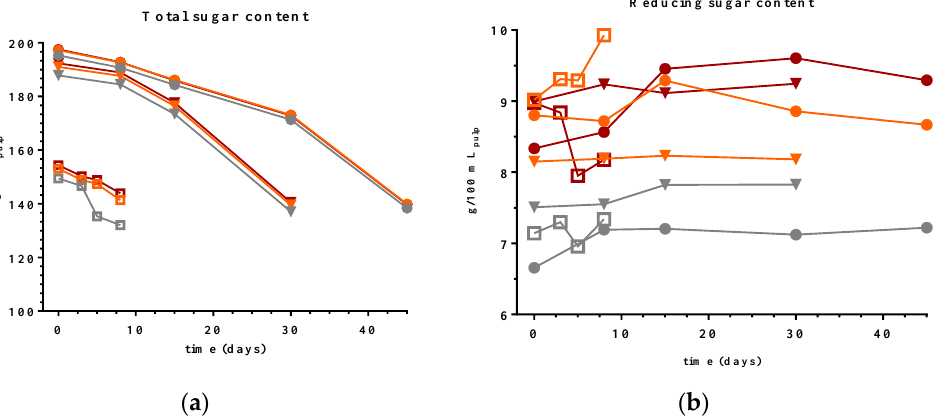
Figure 4. Variation in ( a ) total sugar content and ( b ) reducing sugar content over storage time in Figure 2 . Evaluation of the ( a ) pH and ( b ) titratable acidity in juices of O. ficus-indica versus storage Figure 2 . Evaluation of the ( a ) pH and ( b ) titratable acidity in juices of O. ficus-indica versus storage Figure 2 . Evaluation of the ( a ) pH and ( b ) titratable acidity in juices of O. ficus-indica versus storage prickly pear non-pasteurized samples (raw ( □ )) and the two processing methods (high-pressure time for non-pasteurized samples (raw ( □ )) and the two processing methods (high-pressure time for non-pasteurized samples (raw ( □ )) and the two processing methods (high-pressure time for non-pasteurized samples (raw ( □ )) and the two processing methods (high-pressure processing ( ● ) and thermal pasteurization ( ▼ )). cv ´Rossa´ (red juice) in red ( ▬ ), cv ‘ Gialla ’ (orange processing ( ● ) and thermal pasteurization ( ▼ )). Cv ´Rossa´ (red juice) in red ( ▬ ), cv ‘Gialla’ (orange processing ( ● ) and thermal pasteurization ( ▼ )). Cv ´Rossa´ (red juice) in red ( ▬ ), cv ‘Gialla’ (orange processing ( ● ) and thermal pasteurization ( ▼ )). Cv ´Rossa´ (red juice) in red ( ▬ ), cv ‘Gialla’ (orange juice) in orange ( ▬ ) and cv ‘ Bianca ’ (white juice) in gray ( ▬ ). Results are expressed as averages ± SD. juice) in orange, ( ▬ ) and cv ‘Bianca’ (white juice) in gray ( ▬ ). Results are expressed as averages ± SD. juice) in orange, ( ▬ ) and cv ‘Bianca’ (white juice) in gray ( ▬ ). Results are expressed as averages ± SD. ) and cv ‘Bianca’ (white juice) in gray ( juice) in orange, ( ▬ ) and cv ‘Bianca’ (white juice) in gray ( ▬ ). Results are expressed as averages ±